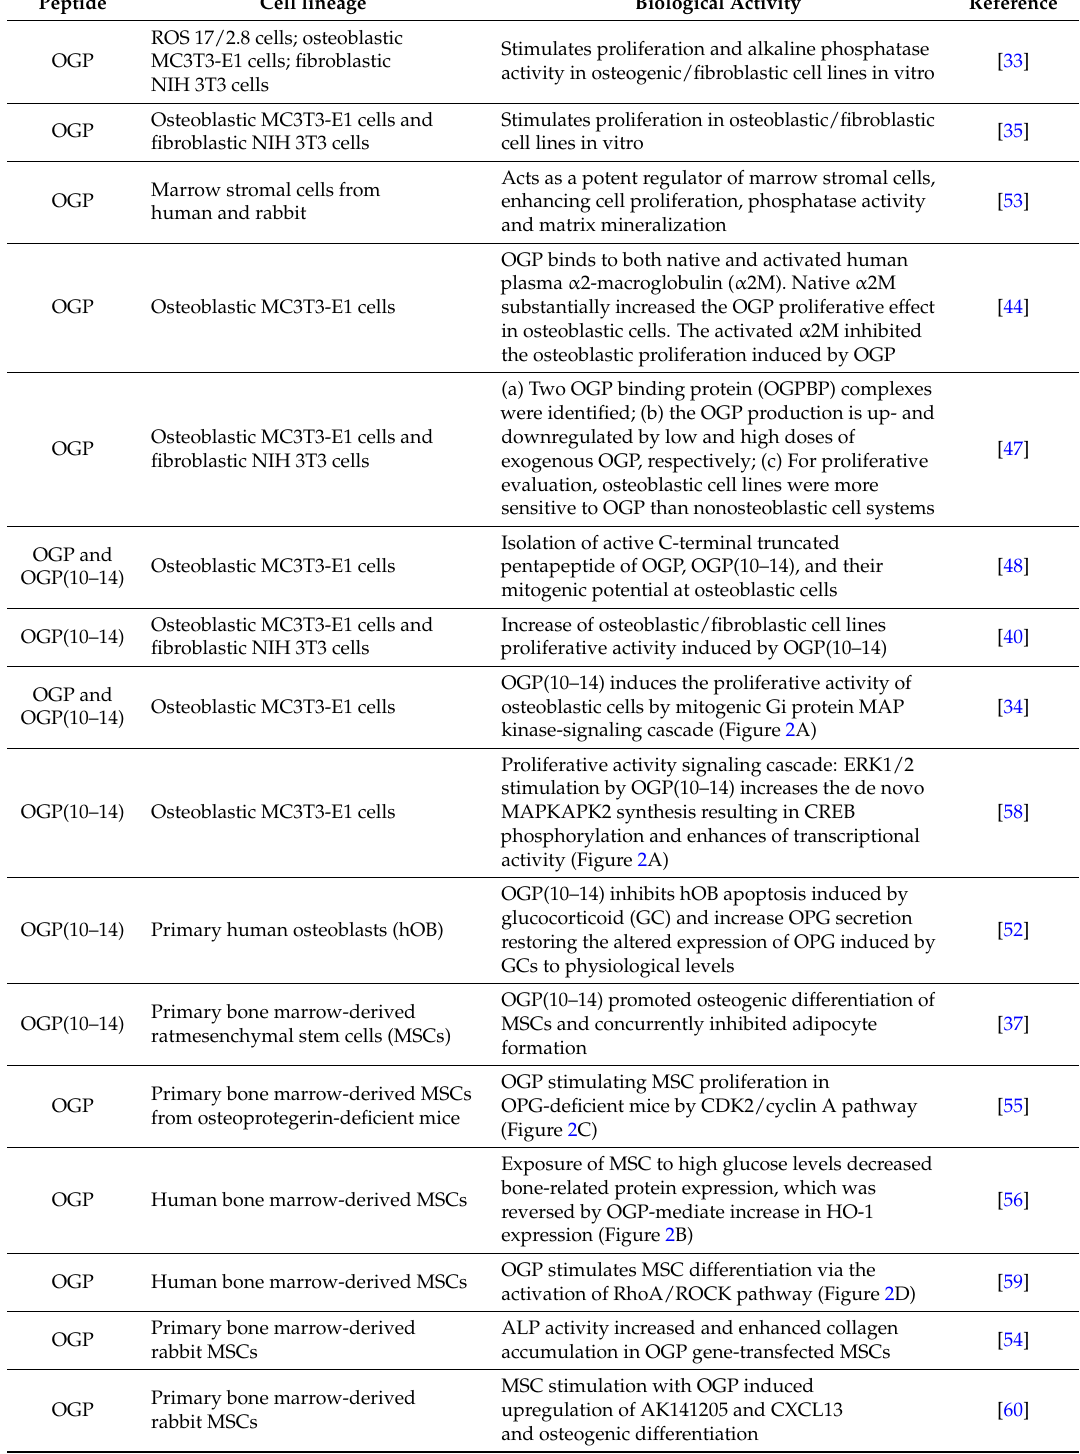
Table 2. OGP and OGP(10–14) in vitro